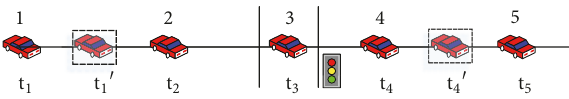
Figure 5: Low-frequency vehicle trajectory at